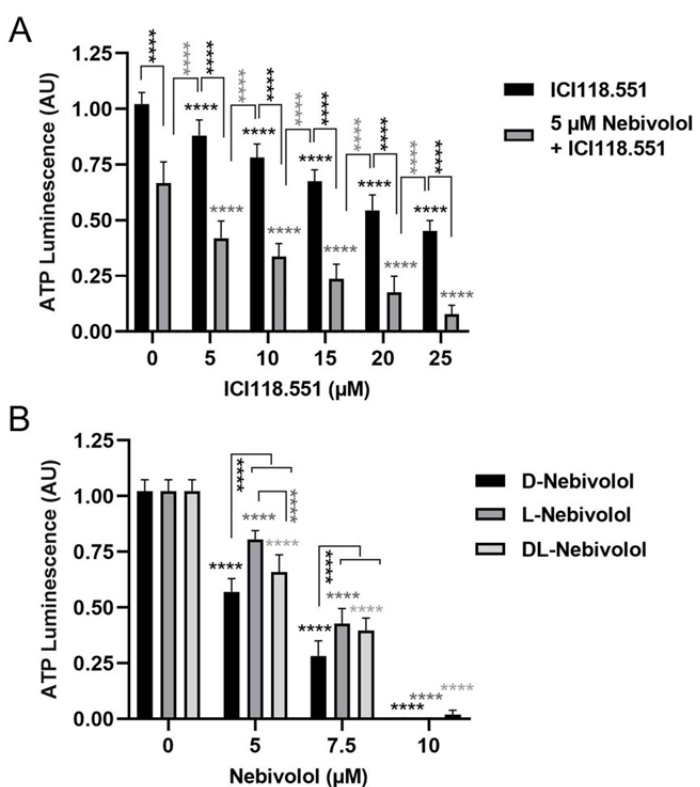
Figure 8. Effects of β 2-adrenoceptor antagonism and of nebivolol enantiomers on ATP levels of Mel270 cells. ( A ) Cells were treated once with β 2-antagonist ICI 118.551 at the indicated concentrations in the absence or presence of 5 µM nebivolol. ( B ) Cells were treated once with either D-nebivolol, L-nebivolol, or racemic DL-nebivolol at the indicated concentrations. After 7 days of incubation, cell ATP was assayed with an ATP luminescence assay. ATP luminescence of treated spheroids was normalized to ATP luminescence of controls (0 µM) and is given in arbitrary units (AU). The means ± SD of three independent experiments with n = 6 cultures each condition shown. Statistical analysis by two - way ANOVA and Tukey’s multiple comparisons test, significance levels were indicated **** p < 0.0001.